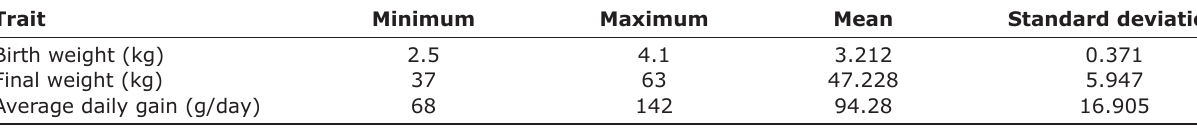
Table-1: Descriptive statistics for phenotypic data.